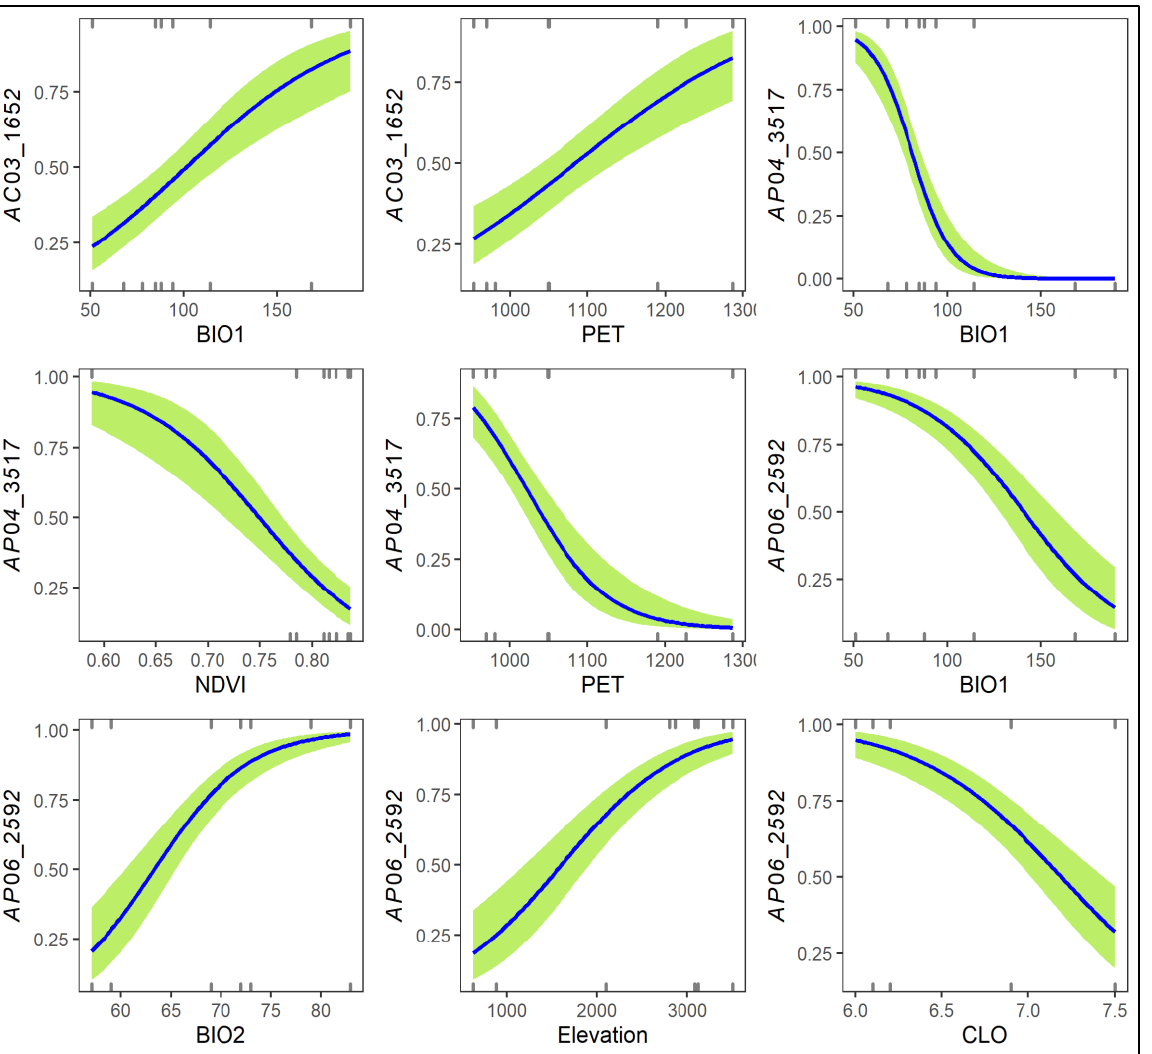
Figure 4. Logistic regression plots of the three AFLP loci associated strongly with environmental variables when comparing the low-elevation Rhododendron rubropunctatum populations with the high-elevation populations of species including R. hyperythrum , R. morii , and R. pseudochrysanthum . Values of the y -axis are the predicted probabilities of AFLP loci and the number of the x -axis are the values of environmental variables. Logistic regression was performed based on the generalized linear model with a logit link function and a binomial residual distribution. The presence/absence of the three loci (AC03_1652, AP04_3517, and AP06_2592) were used as response variables and the environmental variables strongly correlated with the loci were used as predictor variables in analysis using the glm function of R (Supplementary Methods). BIO1, annual mean temperature; BIO2, mean of the difference of the monthly maximum and minimum temperatures; CLO, cloud cover; NDVI, normalized difference vegetation index, PET, annual total potential evapotranspiration.